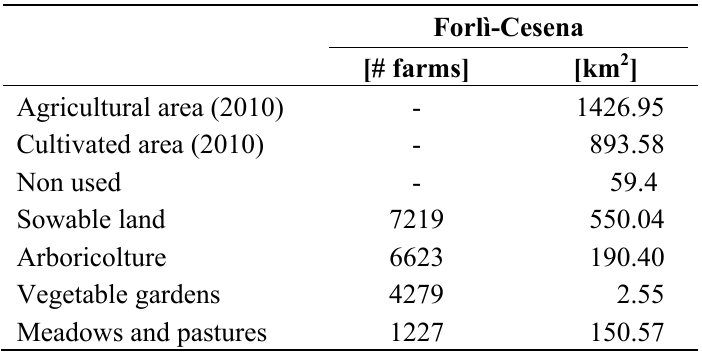
Table 1. Land use in the province of Forlì-Cesena [17].